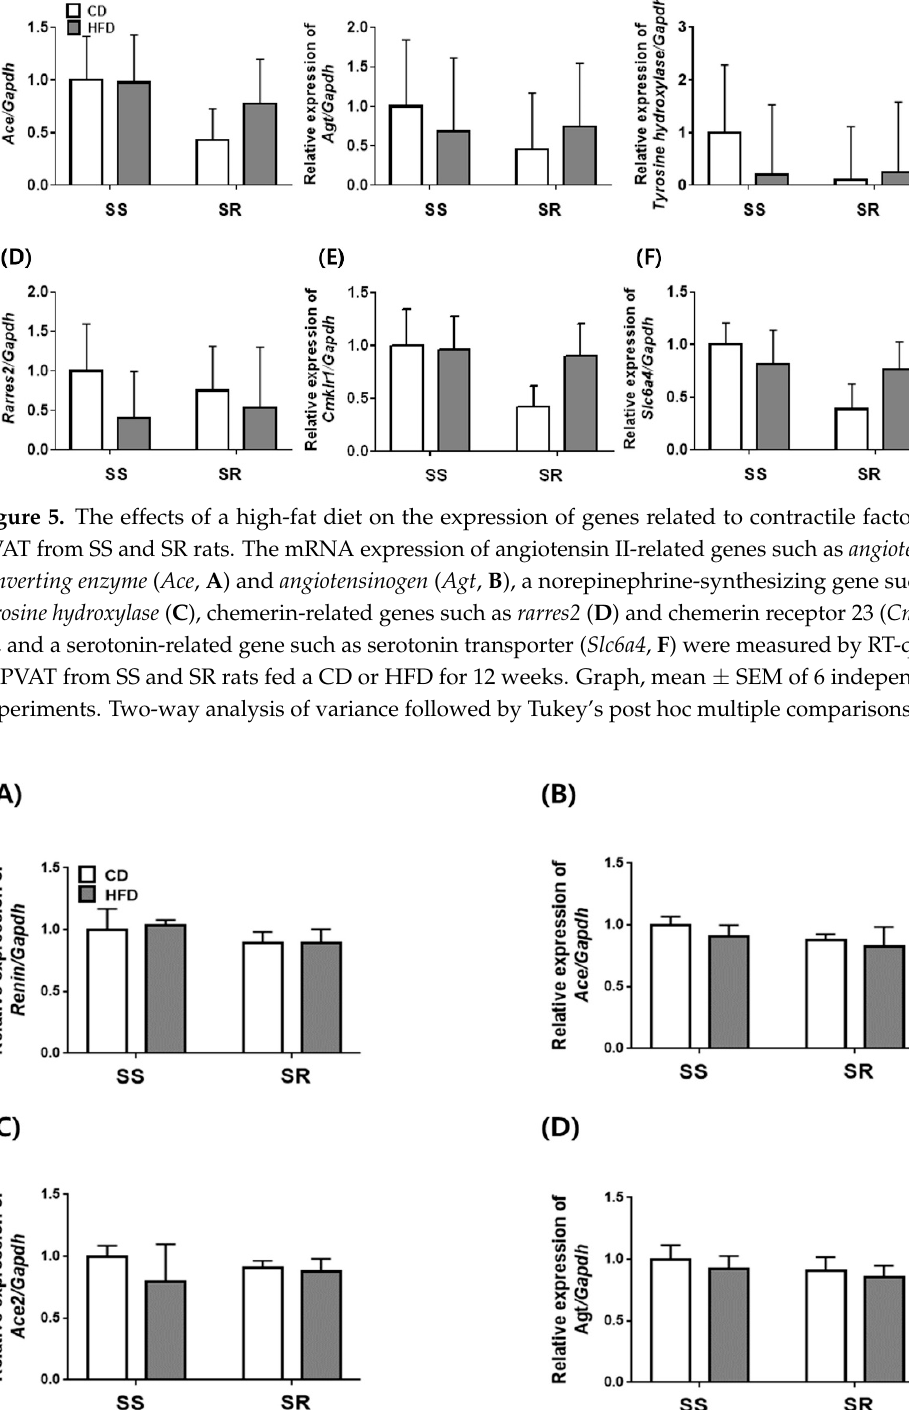
Figure 7. The effects of a high-fat diet on the expression of genes related to angiotensin II receptor in kidney from SS and SR rats. The mRNA expression of angiotensin receptor related genes such as angiotensin II type 1a receptor ( At1ar , A ), angiotensin II type 1b receptor ( At1br , B ), angiotensin II type 2 receptor ( At2r , C ), and mas1 proto-oncogene ( Mas1 , D ) were measured by RT-qPCR in kidney from SS and SR rats fed a CD or HFD for 12 weeks. Graph, mean ± SEM of 6 independent experiments. Two- way analysis of variance followed by Tukey’s post hoc multiple comparisons test. 4. Discussion